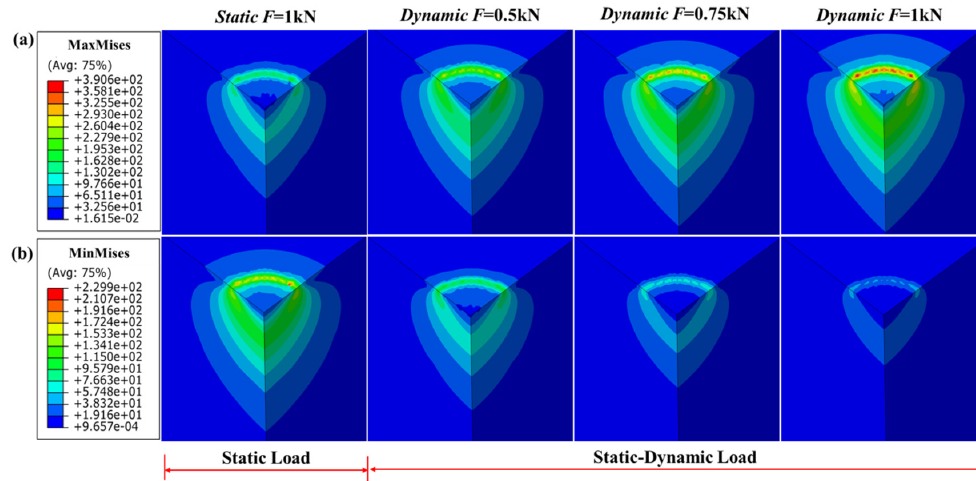
Figure 12. The comparison of Mises stress contour plots under static and static-dynamic loads with different amplitudes of dynamic load for cylindrical indenter: ( a ) MaxMises. ( b ) MinMises.